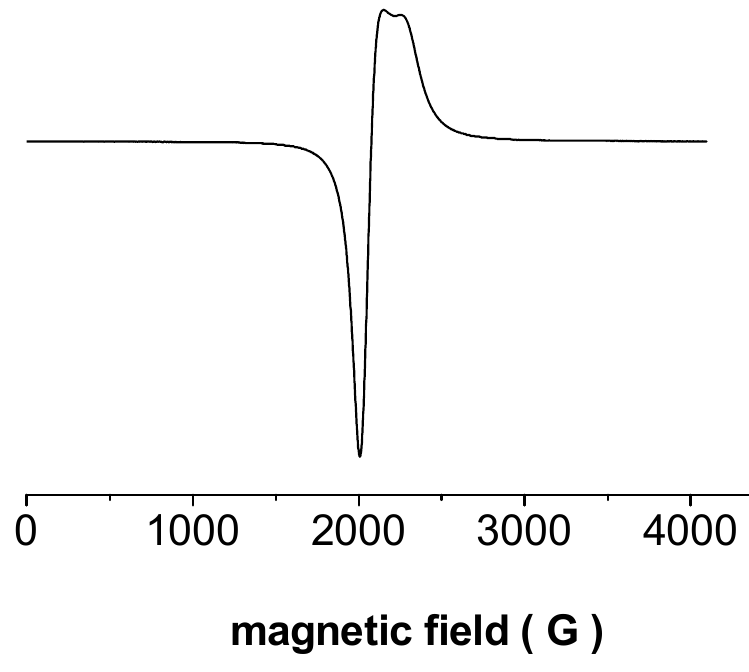
Figure 4. EPR spectrum for Li 1 . 3 V 3 O 8 .